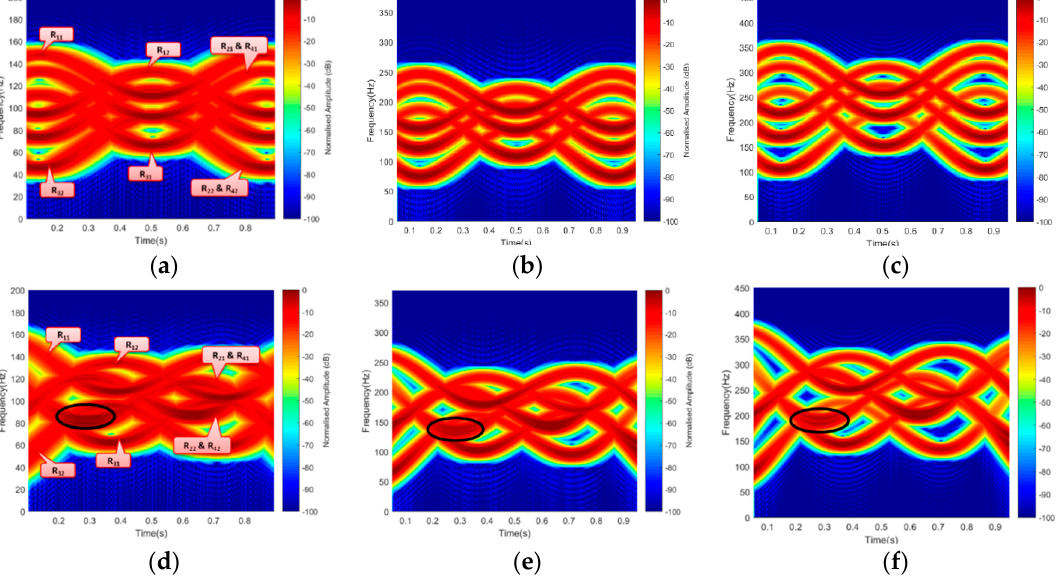
Figure 4. Simulated micro-Doppler from the blade for scenarios: Blade Facing-Rx at ( a ) 3 GHz, ( b ) 5 GHz, and ( c ) 7 GHz. Blade Facing-Up at ( d ) 3 GHz, ( e ) 5 GHZ, and ( f ) 7 GHz. Rx: